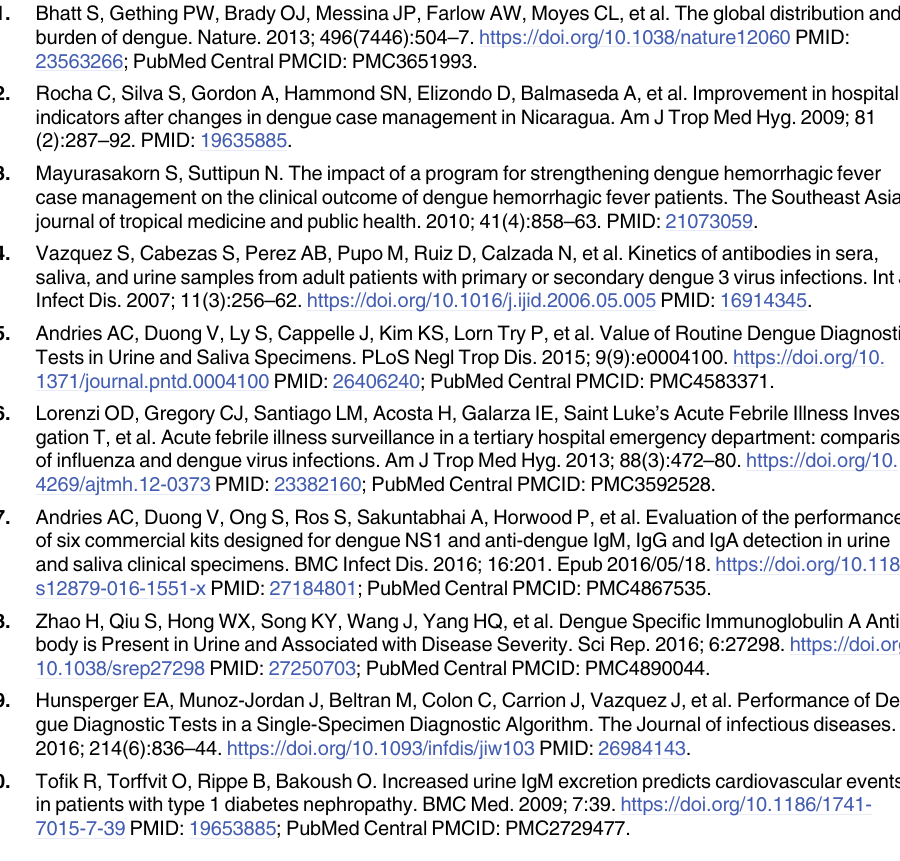
S2 Table. Checklist STROBE